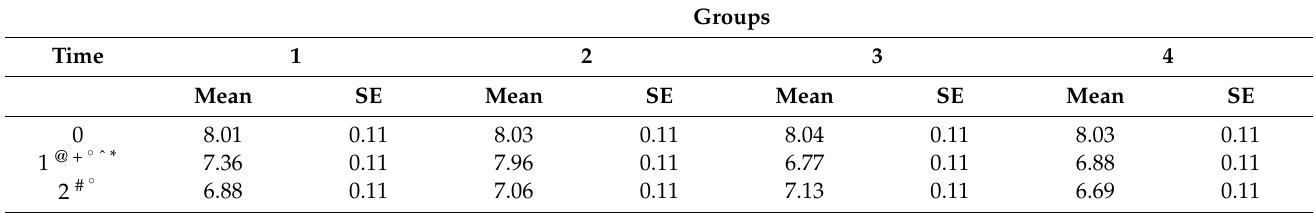
Table 3. TP Parameter: values for each timepoint and group adjusted for baseline